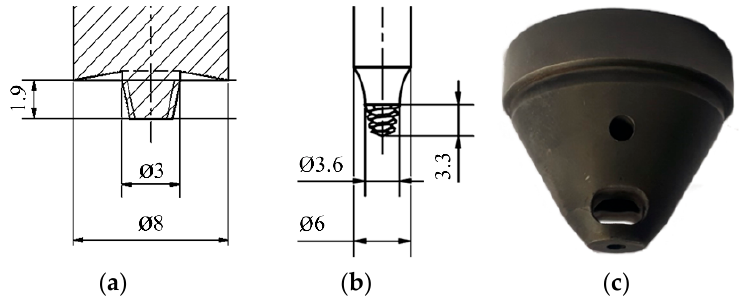
Figure 3. ( a ) Conventional FSW tool, ( b ) probe and ( c ) shoulder of stationary shoulder tool setup with dimesions in mm.